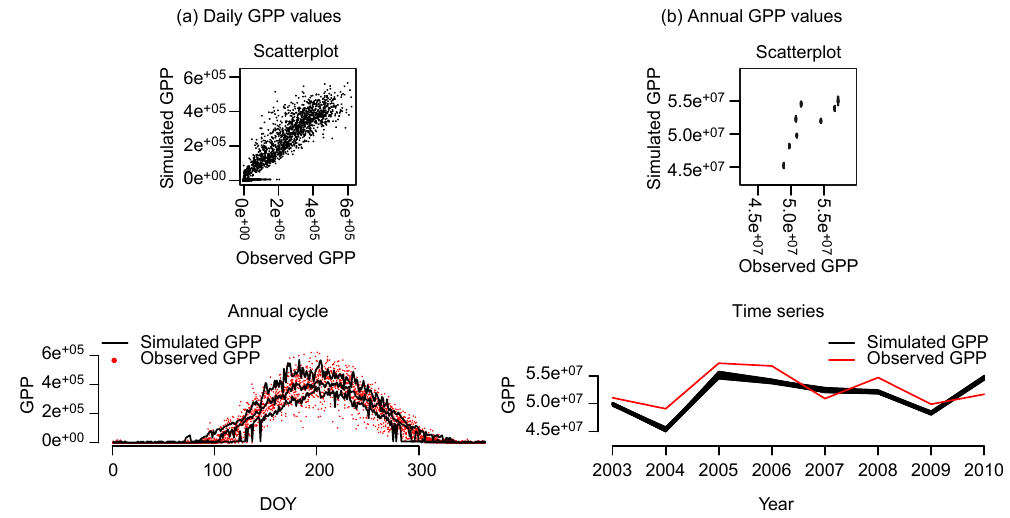
Figure 3. Comparison between observed GPP values and MAIDEN-simulated values at the Quebec Eastern Old Black Spruce site. (a) Daily values (units are µmolCm − 2 day − 1 ) . In the scatterplot ( R 2 = 0 . 90; r = 0 . 95, df = 2918, p < 0 . 001), observations are compared with the values obtained with plausible block GPP. In the annual cycle plot, black lines are the medians and the 5th and the 95th percentiles of the simulated values from all iterations retained by the MCMC sampling. (b) Annual values (units are µmolCm − 2 yr − 1 ) . In both plots, observations are compared with the values from all iterations retained by the MCMC sampling. In the scatterplot, the R 2 of the data is 0.31 ( r = 0 . 76, df = 6, p < 0 . 05).